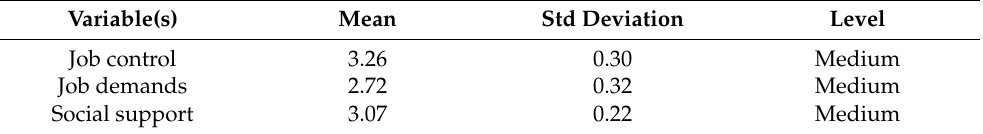
Table 5. The results of the descriptive statistics and level of job control, job demands and social support.